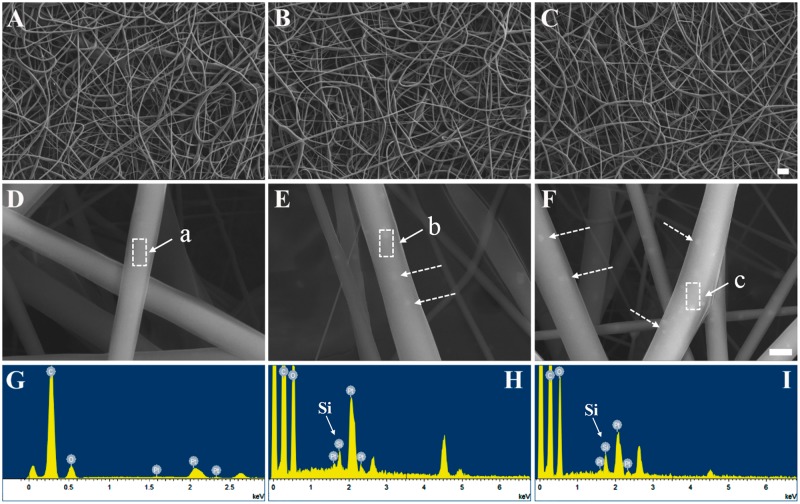
SEM images of PLGA (A, D), PLGA/SiO2-2.5 (B, E) and PLGA/SiO2-5 (C, F) fibers and EDX analysis of area a (G), b (H) and c (I). The composite fibers show silica NPs on the surface (dotted arrows in E and F). The bar for A, B and C is 5 μm and for D, E and F is 500 nm